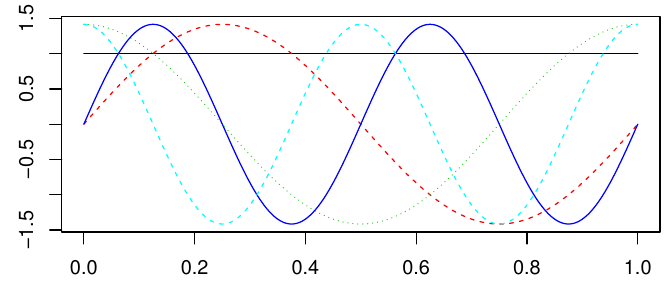
Figure 2. Fourier basis function system with K = 5 and T =